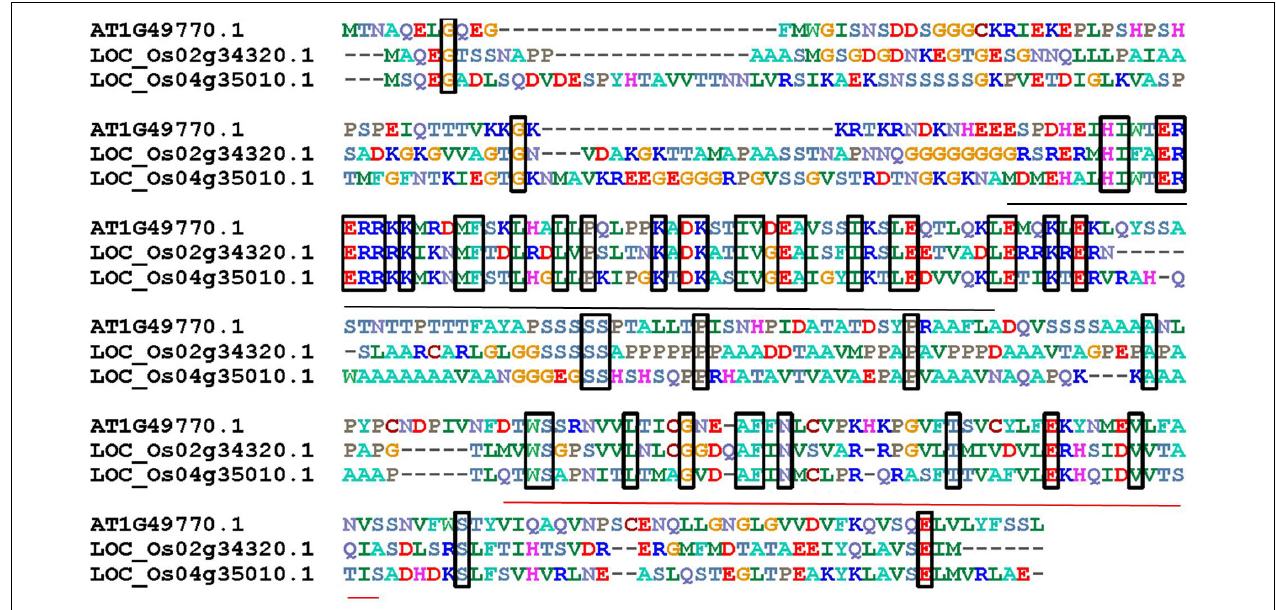
FIGURE 1 | The alignment of AtZOU and two most closely related rice homologs. Alignment of amino acid sequences of AtZOU (AT1G49770.1) with OsZOU-1 (LOC_Os04g35010) and OsZOU-2 (LOC_Os02g34320) genes. Identical amino acids shared between these three proteins are framed in black rectangles; the bHLH region is indicated by a black line below the alignment, while the conserved region at the C-termini of proteins is indicated with a red line below the